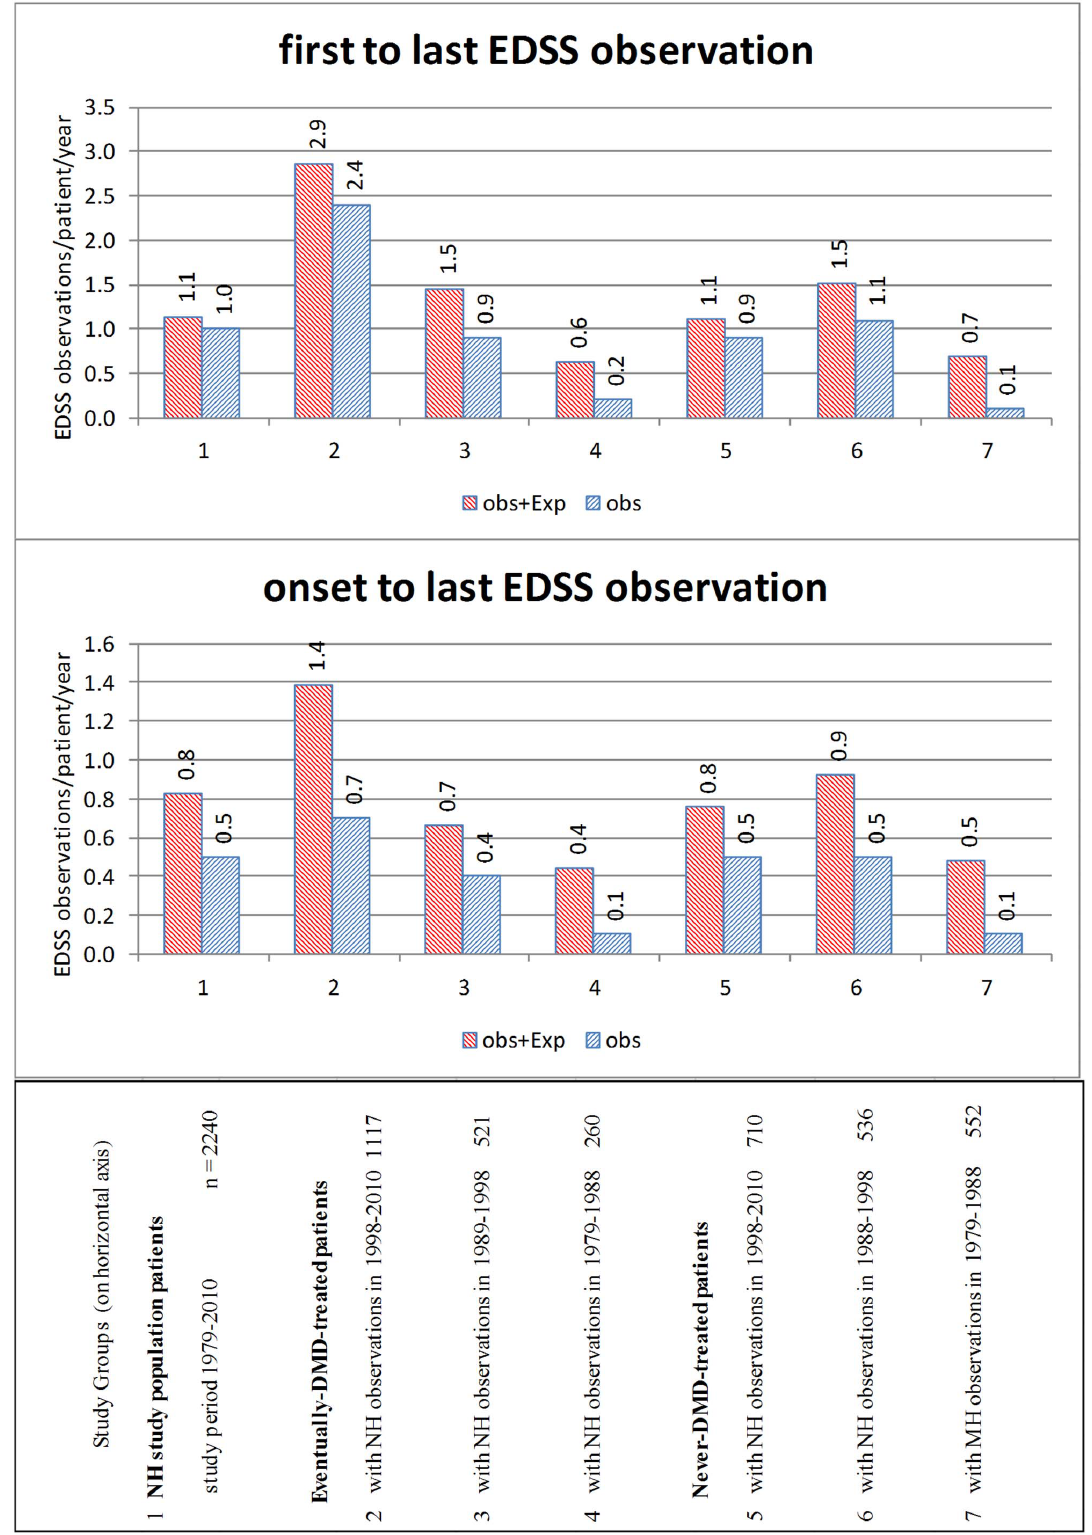
Figure 5. Assessment rates for EDSS clinical observations (obs) and expected midpoint observations (Exp), by relapsing-onset MS study groups and study periods, Nova Scotia, 1979–2010. Footnote: obs=an EDSS clinical observation. obs + Exp=obs and expected EDSS measures, assuming midpoint survival time at irreversible disability endpoints.